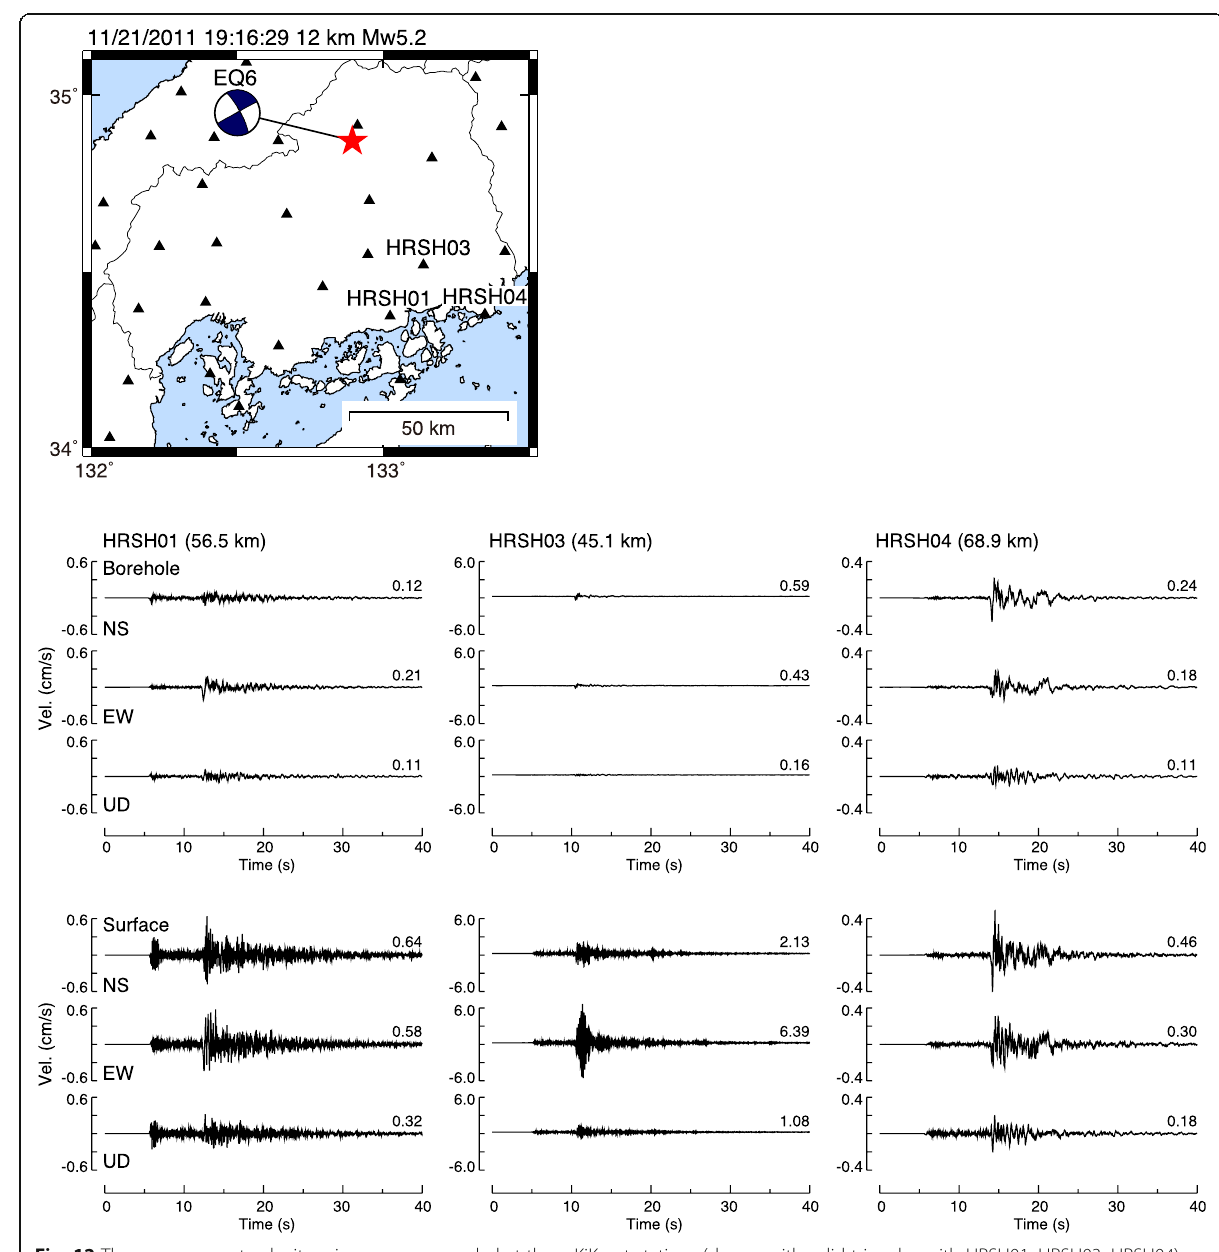
Fig. 12 Three-component velocity seismograms recorded at three KiK-net stations (shown with solid triangles with HRSH01, HRSH03, HRSH04) in the borehole (upper three traces) and on the ground surface (lower three traces) in Hiroshima Prefecture for an event of November 21, 2011 (Mw5.2) (EQ6 in Table 3 in Appendix). Here, the waveform amplitudes are normalized by the maximum amplitude at each station, and the number above each trace is the PGV (cm/s)